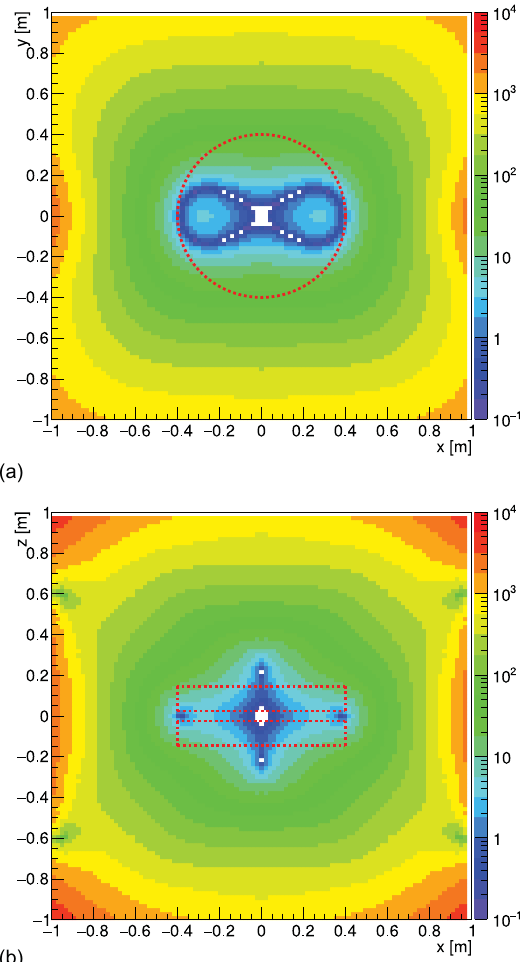
Figure 3. B 0 field uniformity. Calculated magnetic field deviation in pT from the nominal 1 µ T for the B 0 coil. The B 0 field is aligned with the z-axis on the graphs. The red disc (3a) and the boxes (3b) represent the UCN chambers with a diameter of 80cm and a height of 12cm. The UCN chambers are within the 10 − 4 field uniformity region, i.e., 100 pT on a 1 µ T field.